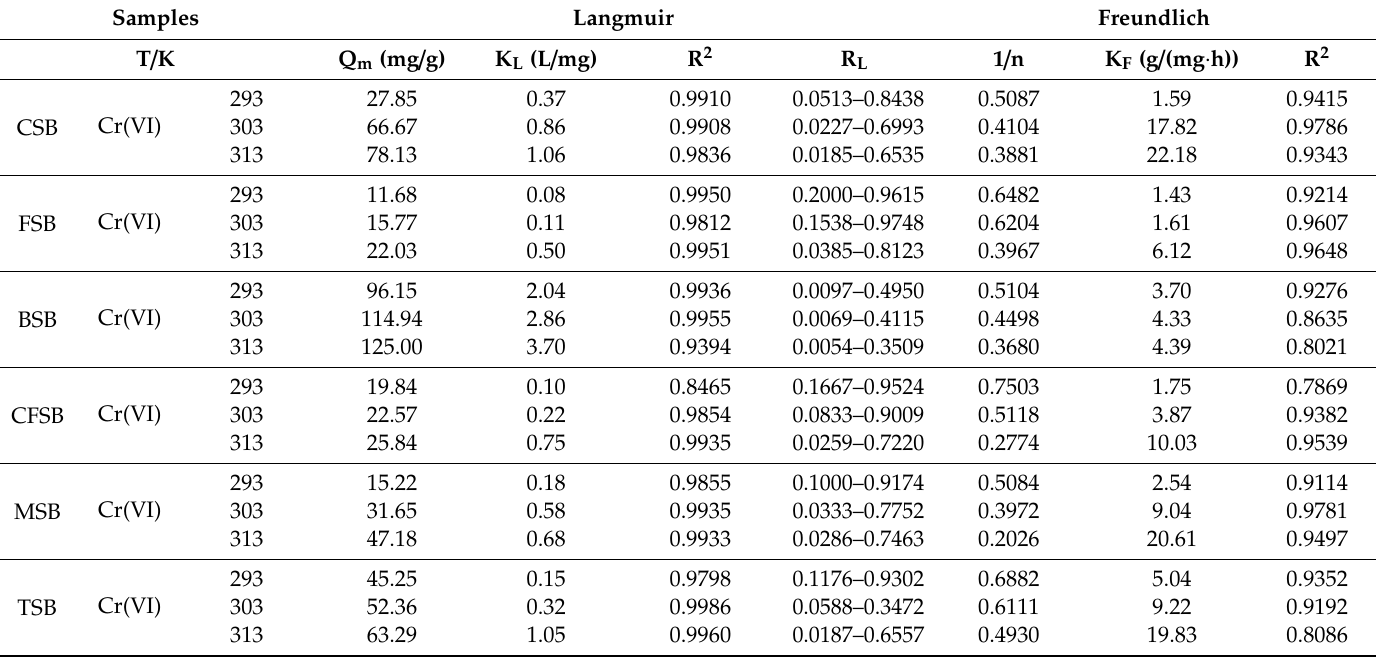
Table 3. Adsorption parameters of the isotherm models for Cr(VI) for the six di ff erent biochars.